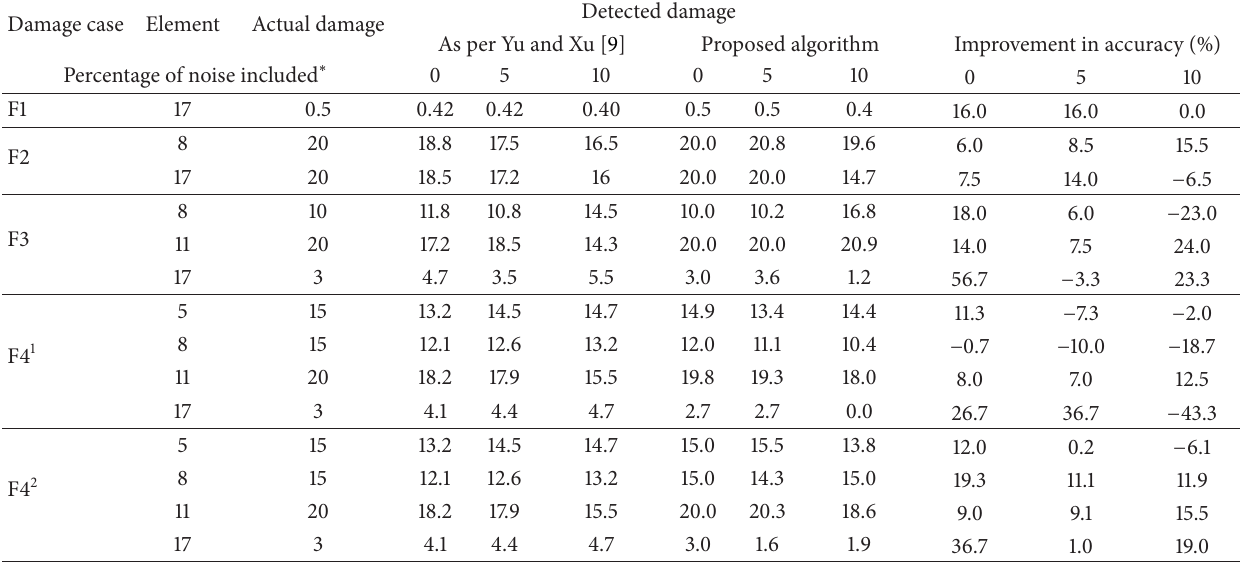
Table 6: Comparison of damage scenario between the present algorithm and [9]. Damage case Element Actual damage Proposed algorithm Improvement in accuracy (%)